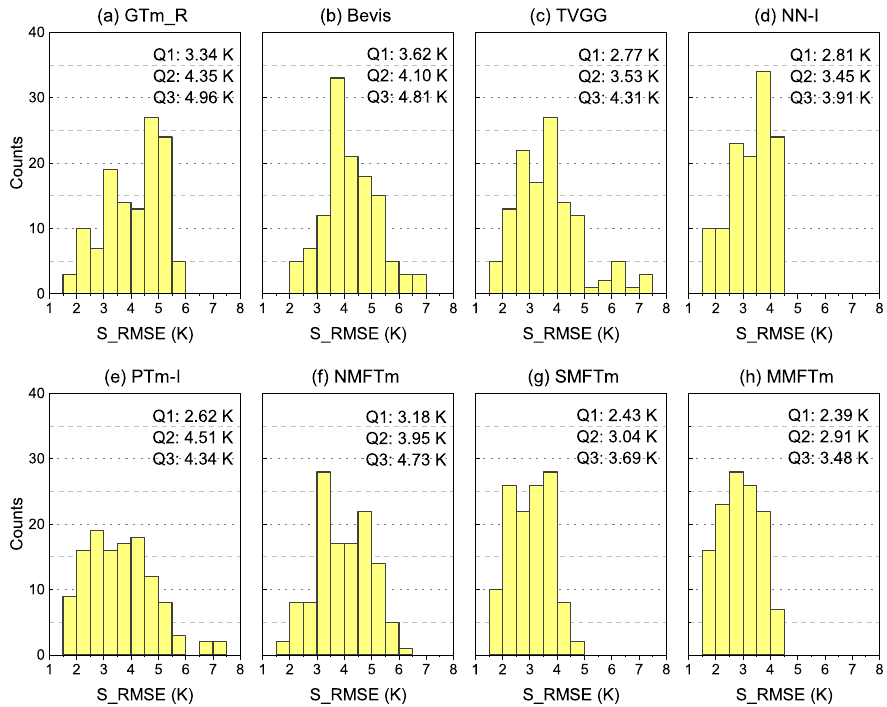
Figure 13. Histograms of S_RMSE for different models tested by radiosonde data from 2016 to 2018 ( a – h